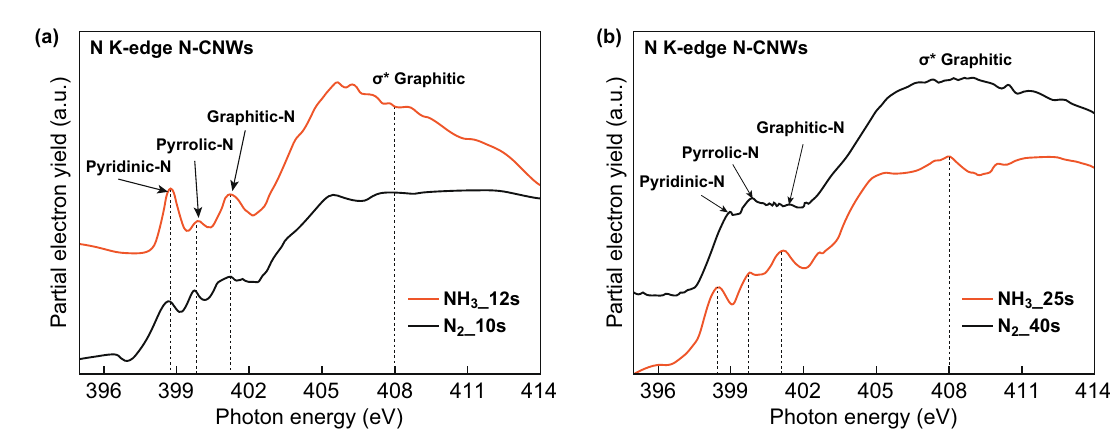
Fig. 8 N K-edge spectra of the NH 3 and N 2 plasma-treated CNWs at different plasma exposure